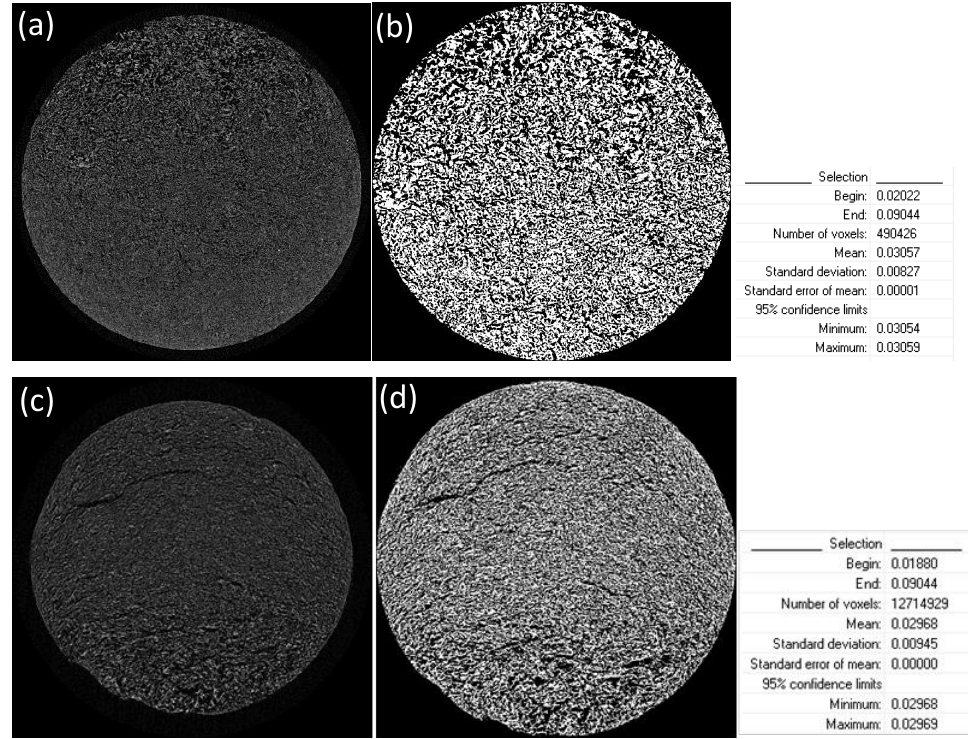
Figure 2. Application of a threshold window from: 0.01880 to 0.09044 AT for scaffolds without crosslinking ( a ) before threshold application and ( b ) after thresholding; and 0.02022 to 0.09044 AT for scaffolds crosslinked with 0.01% riboflavin ( c ) before threshold application and ( d ) after thresholding.